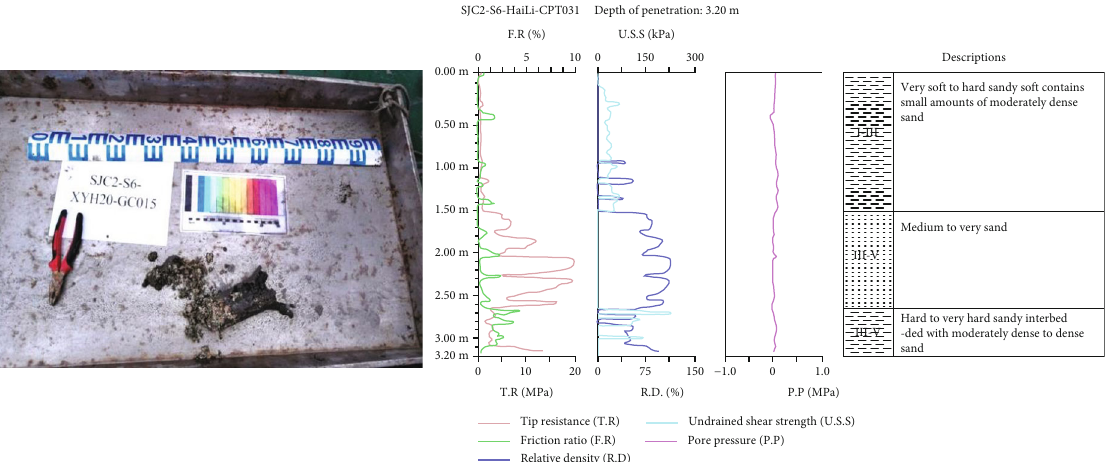
Figure 13: Sediments and CPT results at the top of the sand ridge in a typical erosion depression geomorphic area.